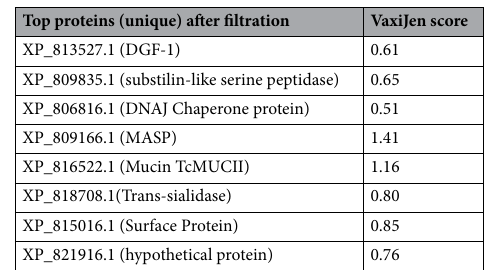
Table 3. Ranking of unique proteins with the highest antigenic score. Here the hypothetical protein has displayed similarity with regulator sigma E protease during the Blast search.